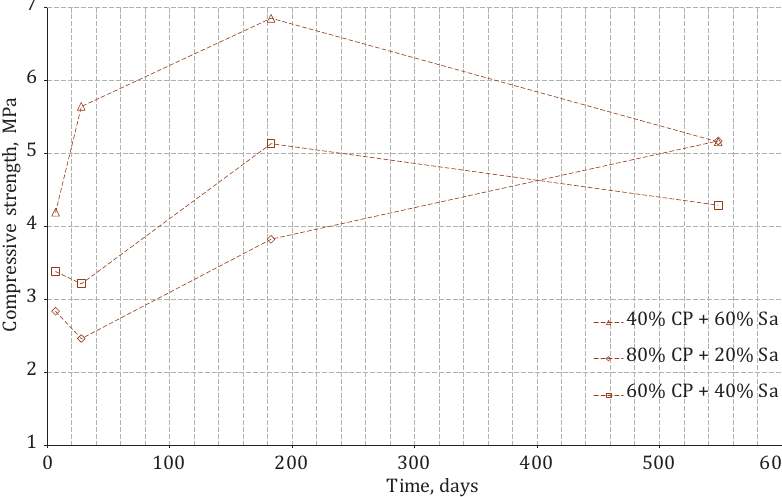
Figure 8. Updated compressive strength of